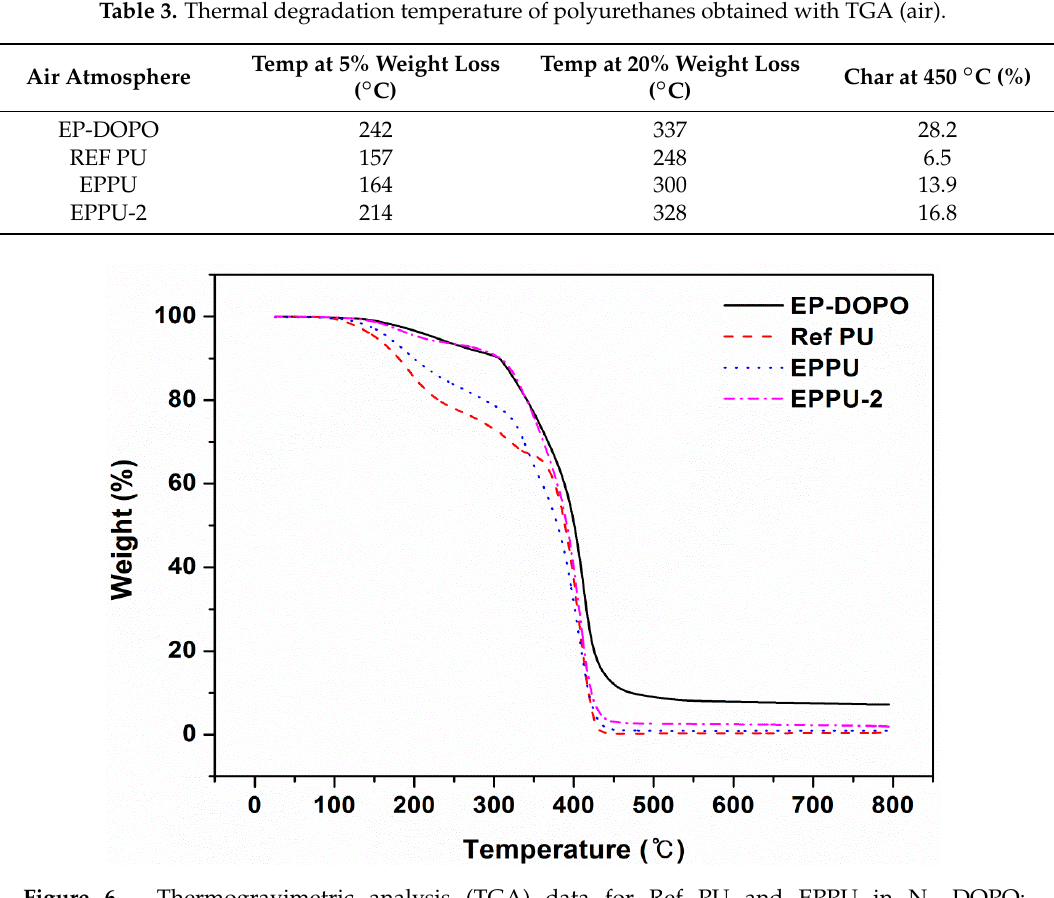
Figure 7. TGA data for Ref PU and EPPU in air. Table 2. Thermal degradation temperatures of polyurethanes obtained with thermogravimetric analysis (TGA) (N 2 ). N 2 Atmosphere Temp. at 5% Weight Loss (°C)